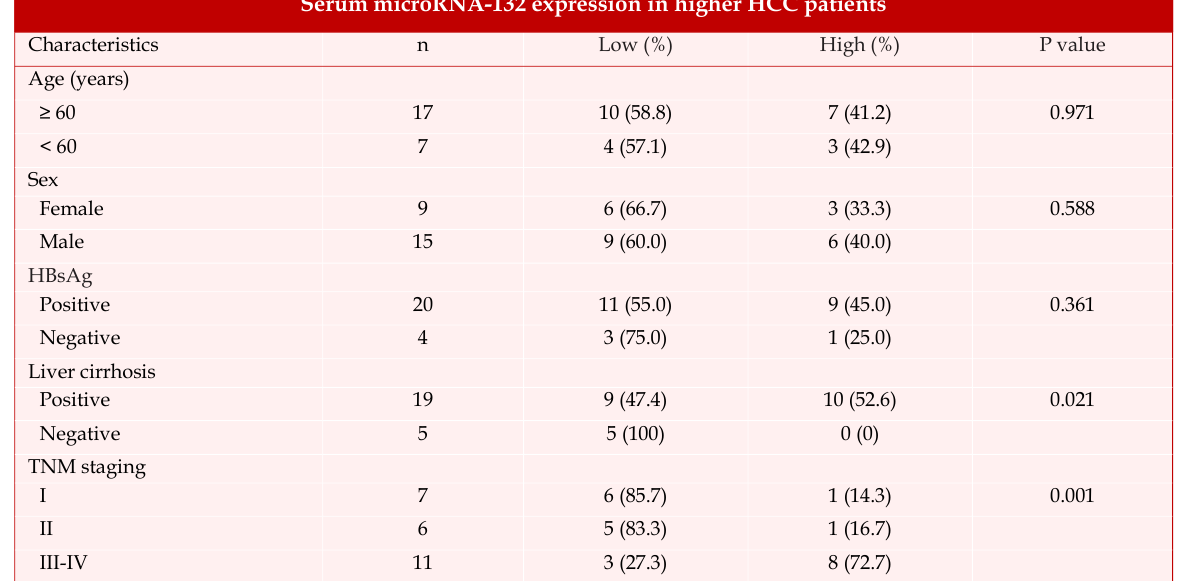
Serum microRNA-132 expression in higher HCC patients